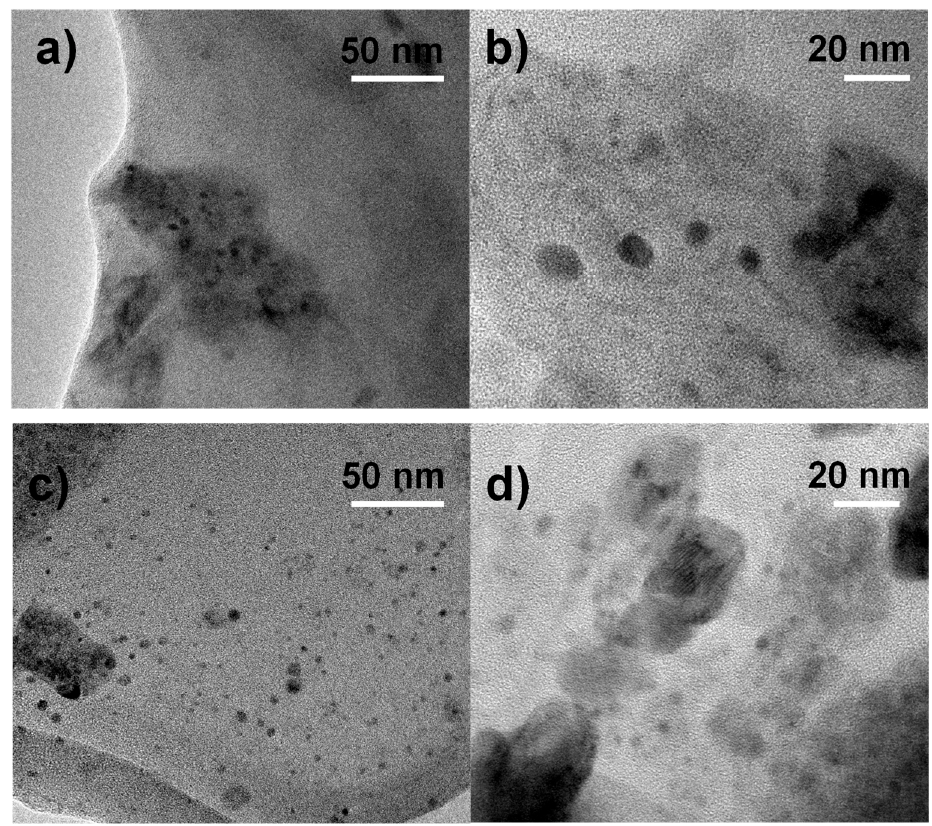
Figure 7. Transmission electron microscopy (TEM) images of PS/2MgZnAl-AAC (15 wt.%) ( a ) Low magnification, ( b ) High magnification, of PS/Mg2ZnAl-AAC (15 wt.%), ( c ) Low magnification image, and ( d ) High magnification.